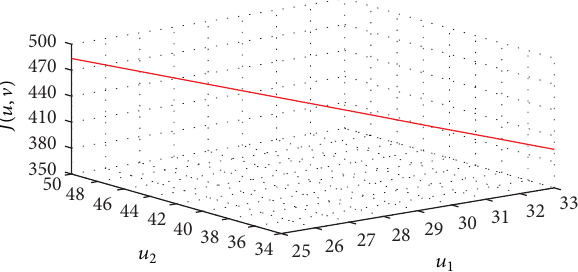
Table 2: The feasible solutions of the game problem when setting the different values of 𝛼 and 𝛽 change with 𝑇 = 3 , 𝑀 0 = 𝑁 0 = 100